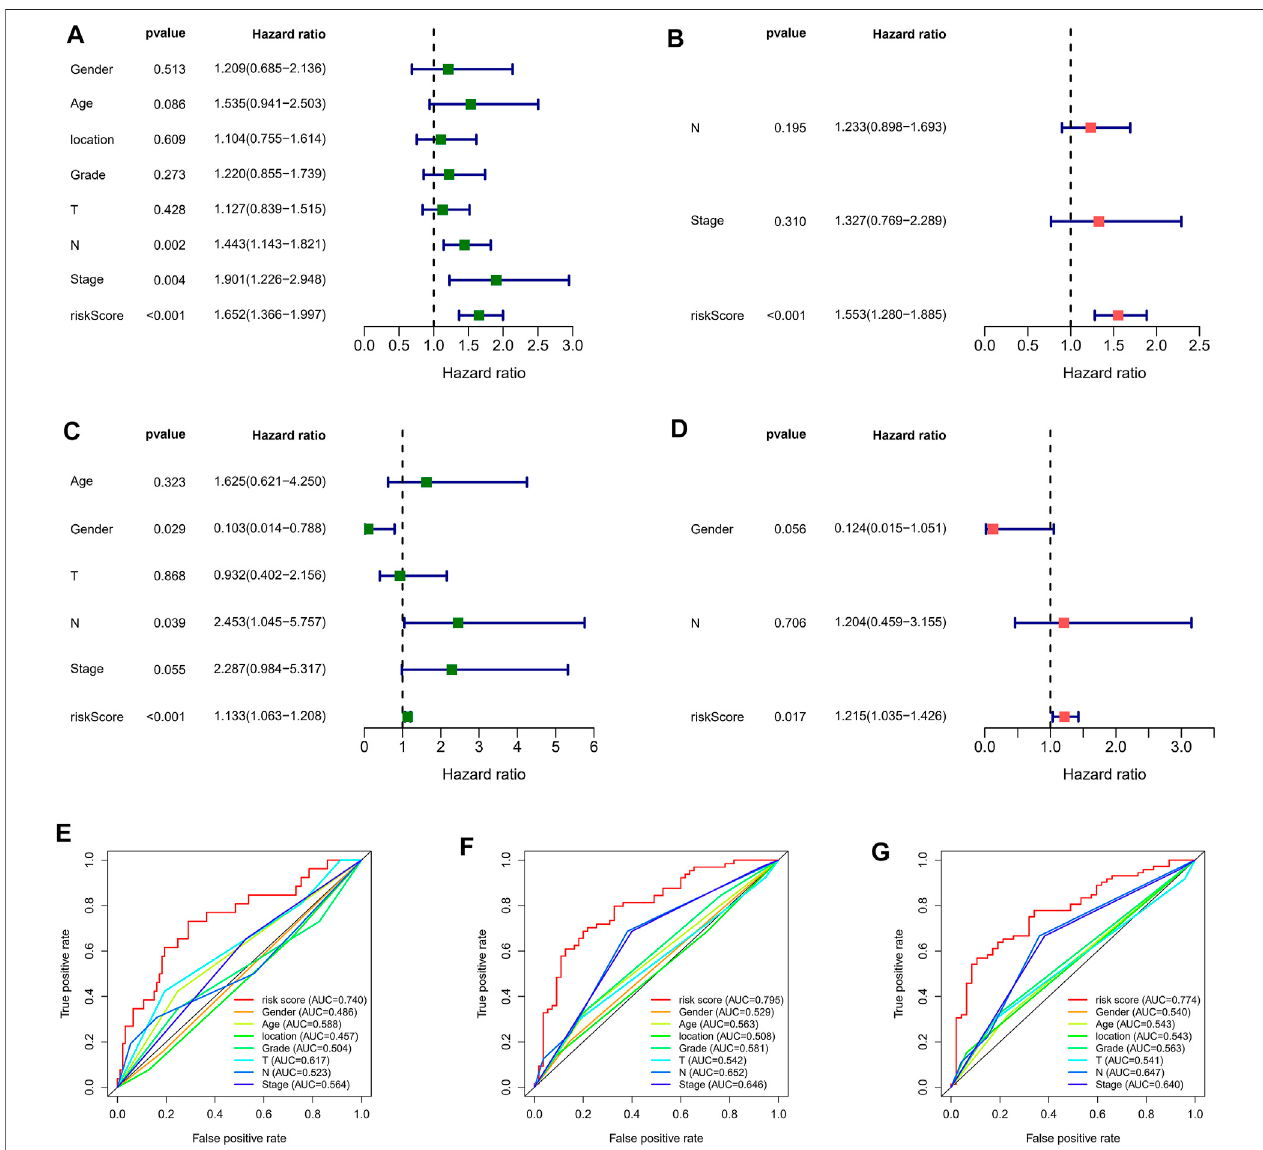
FIGURE 5 | Independent prognostic value of risk score. Univariate Cox regression analysis of the risk scores in GEO (A) and TCGA cohorts (B) . Multivariate Cox regression analysis of the risk scores in GEO (C) and TCGA cohorts (D) . ROC curves of 1- (E) , 3- (F) , and 5-years (G) OS predicted by the nomogram.